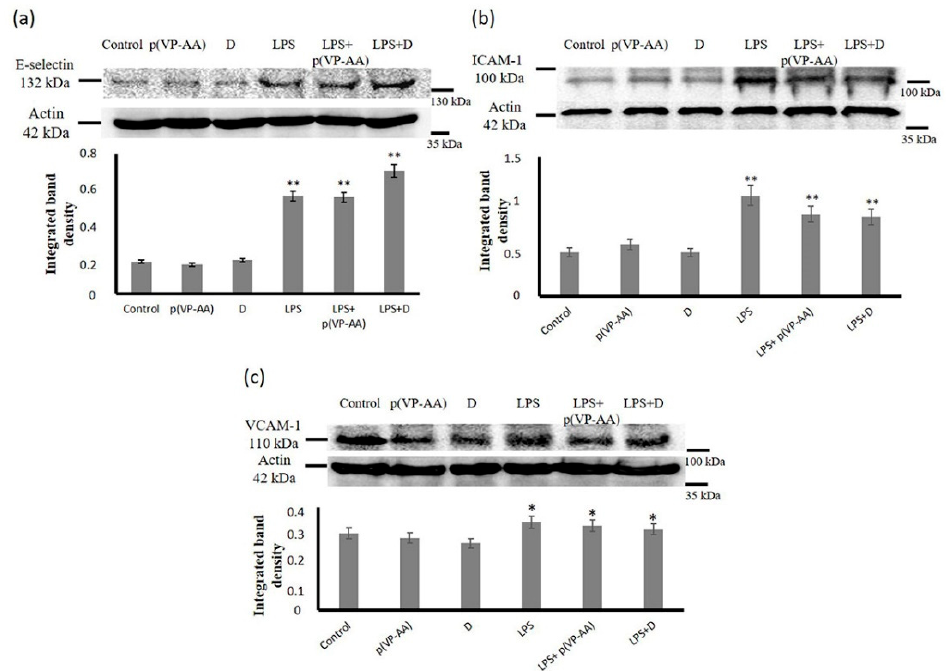
Figure 9. Effect of p(VP-AA) and DNPs on the expression of HMEC-1 cells adhesion molecules. ( a ) Effect of-p(VP-AA) NPs on E-selectin expression of basal state and LPS-activated HMEC-1 cells; ( b ) Effect of p(PV-AA) NPs on the expression of the ICAM-1 of basal state and activated HMEC-1 cells; ( c ) Effect of p(PV-AA) NPs on the expression of the VCAM of basal state and activated HMEC-1 cells. The results represent the average of three separate experiments. Statistical significance: * p ≤ 0.05, ** p ≤ 0.01, compared to respective controls.